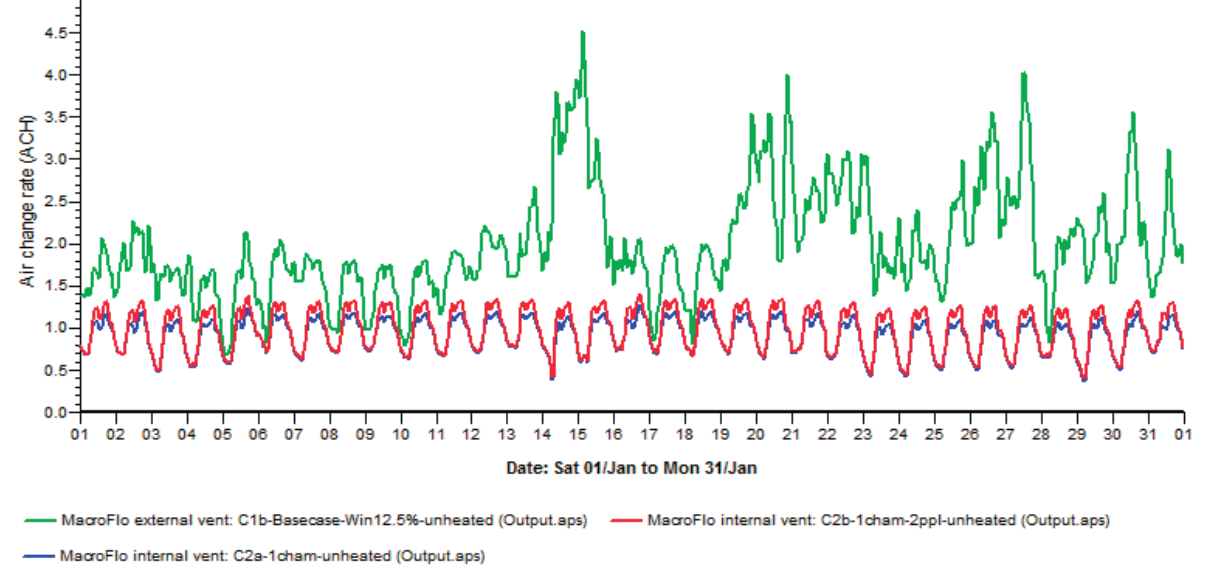
Figure 11. Intermittent ventilation in Case 1b compared to more steady rates in NVHR Cases 2a and